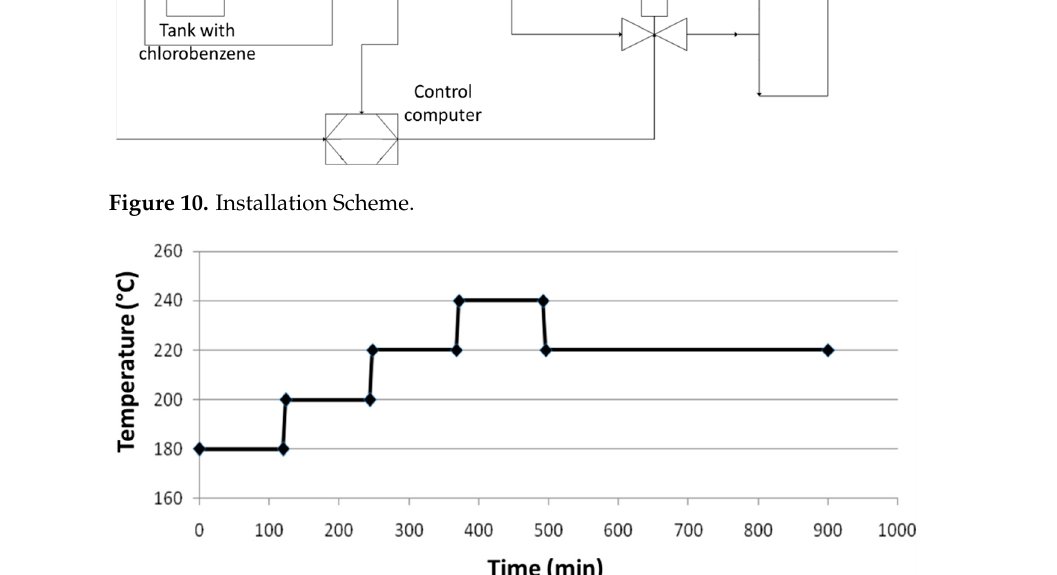
Figure 11. Temperature profile used for the catalytic experiments.